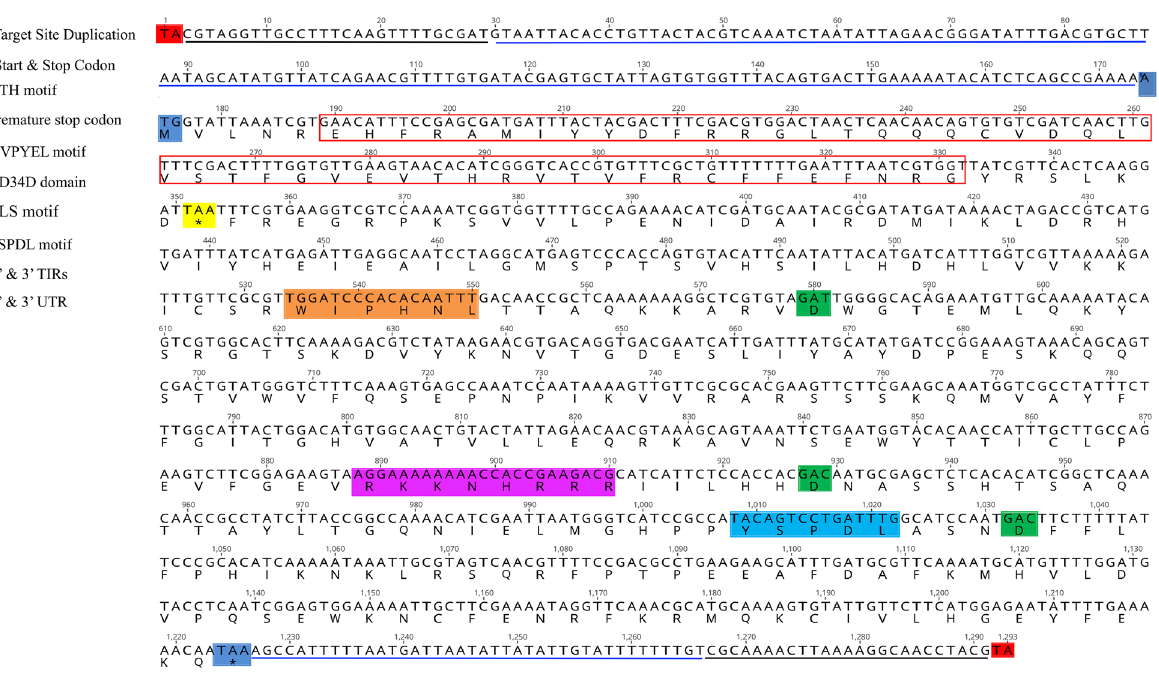
Figure 3. Full length sequence of MLE ( Mfmar4 ) from Drosophila subfamily in Meithanaphis flavogallis with slightly modified W(L)VPY(K)E(V)L motif and NLS for transposase.